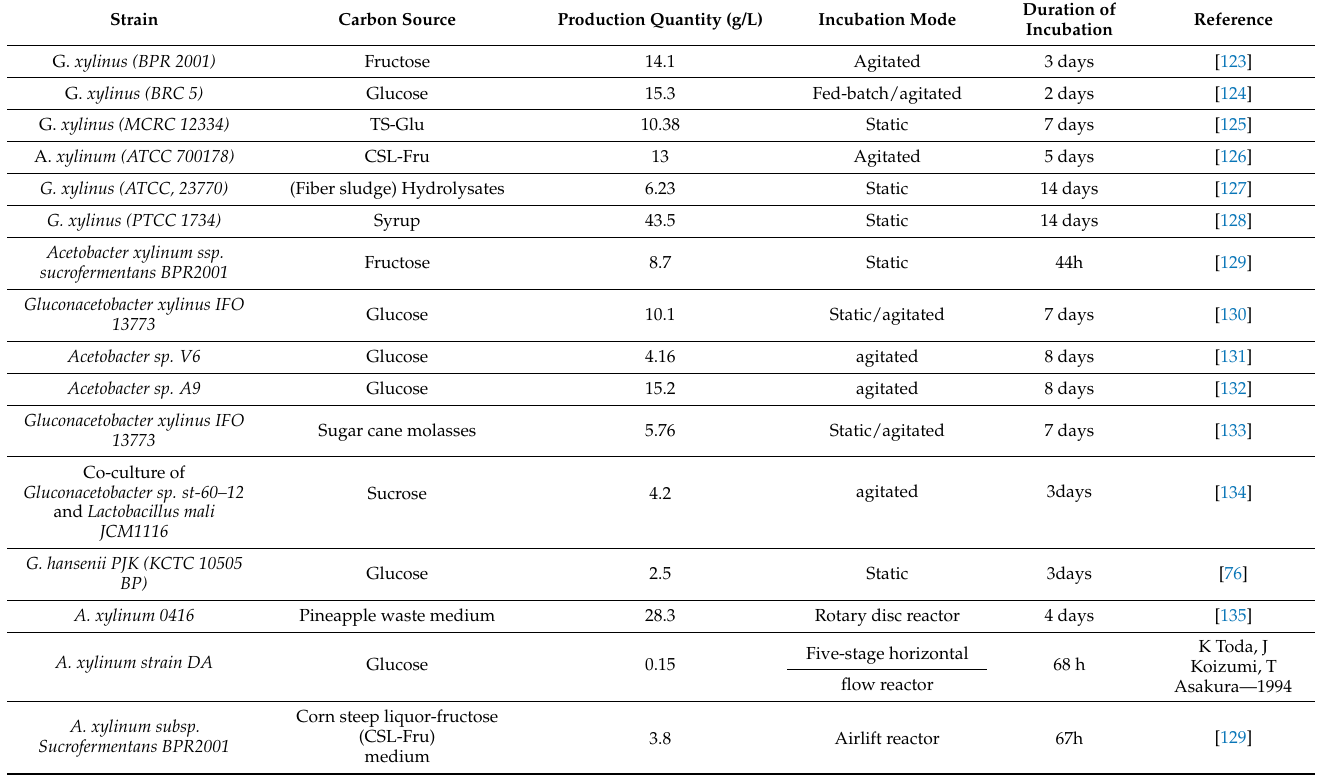
Table 3. Cellulose-producing bacteria strains that have been heavily studied